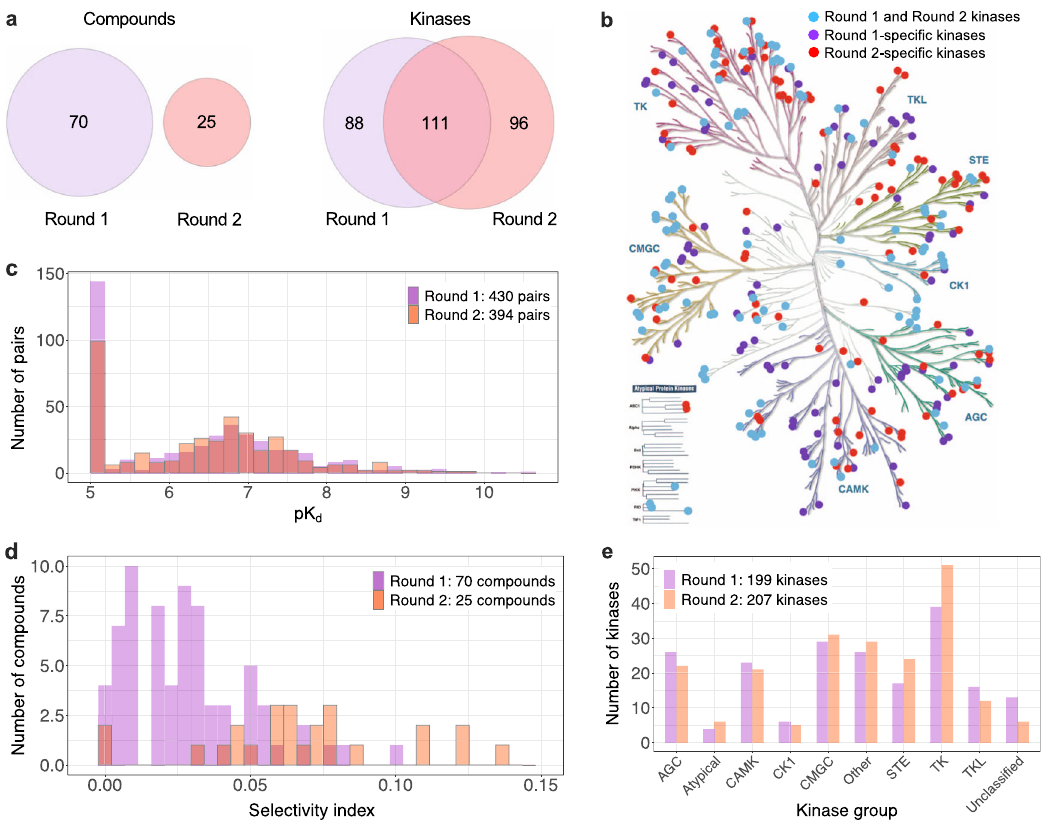
Fig. 2 Challenge test datasets. a The overlap between Round 1 and Round 2 kinase inhibitors and kinase targets, and their distributions in the kinome tree ( b ), and across various kinase groups ( e ). c The quantitative dissociation constant ( K d ) of compound-kinase activities was measured in dose-response assays (see Methods), presented in the logarithmic scale as pK d = − log 10 (K d ). The higher the pK d value, the higher the inhibitory ability of a compound against a protein kinase (Supplementary Data 1 includes the compounds and kinases in Round 1 and Round 2 test datasets). The frequent values of pK d = 5 originate from inactive pairs (maximum tested concentration of 10 µ M in the multi-dose activity pro fi ling). d The selectivity index of kinase inhibitors was calculated based on the single-dose activity assay (at 1 µ M concentration) across the full compound-kinase matrices before the Challenge. The kinome tree fi gure was created with KinMap, reproduced courtesy of Cell Signaling Technology, Inc. Source data are provided as a Source Data fi le 54